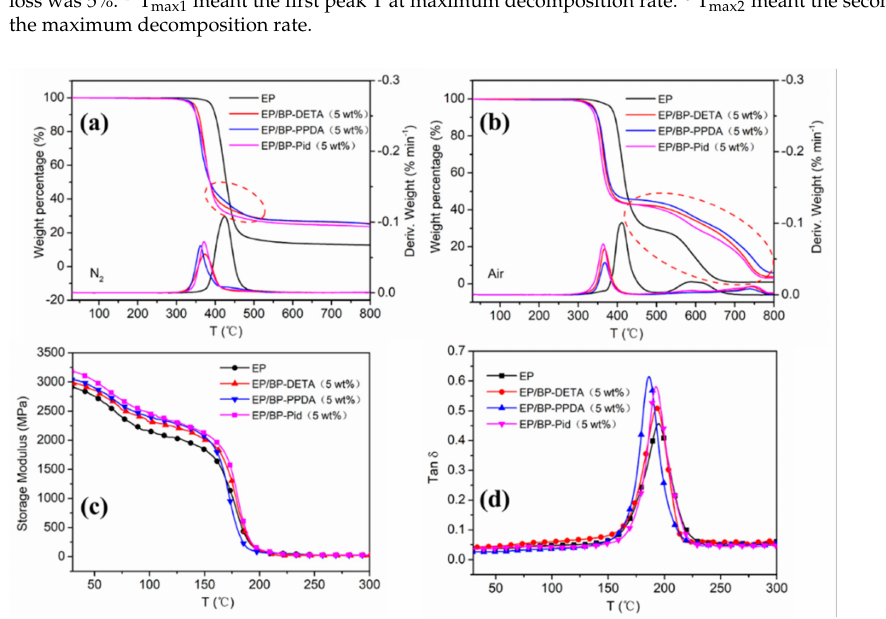
Figure 5. TGA and DTG curves of the pure EP and EP/BP-NH 2 nanocomposites under N 2 ( a ) and under air ( b ); DMA results of the pure EP and EP/BP-NH 2 nanocomposites: storage modulus E’ ( c , d ) tan δ